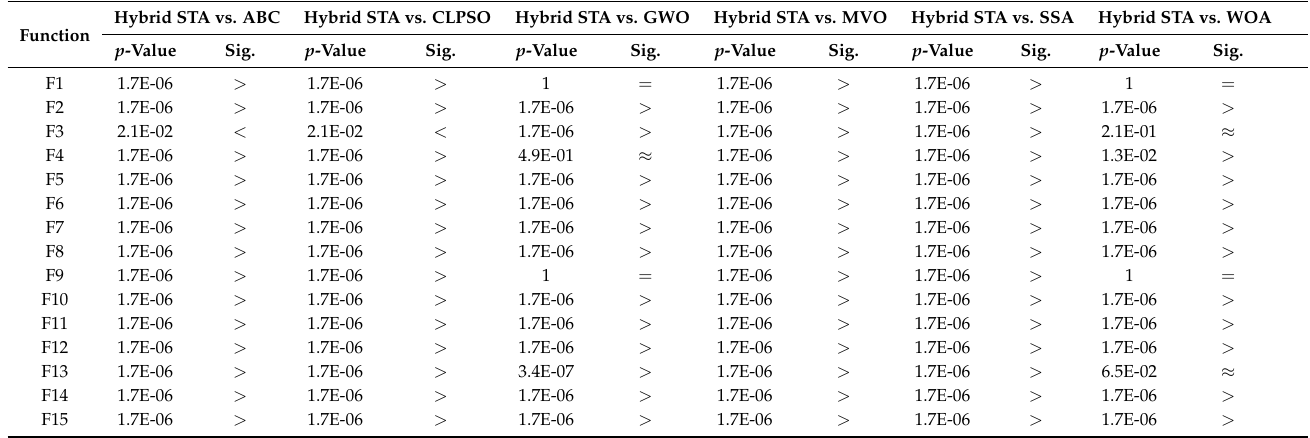
Table 10. Wilcoxon signed-rank test in 30